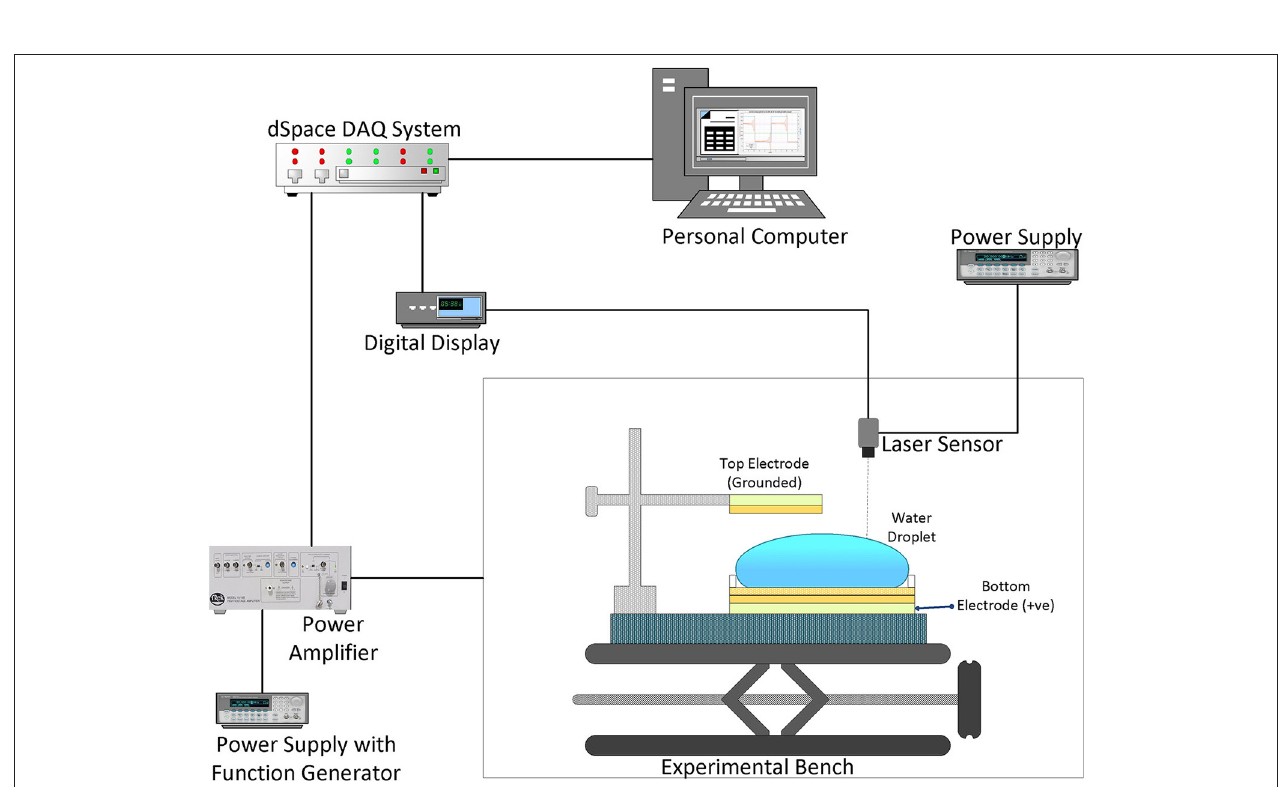
FIGURE 4 | Images of the actual water droplet movement.